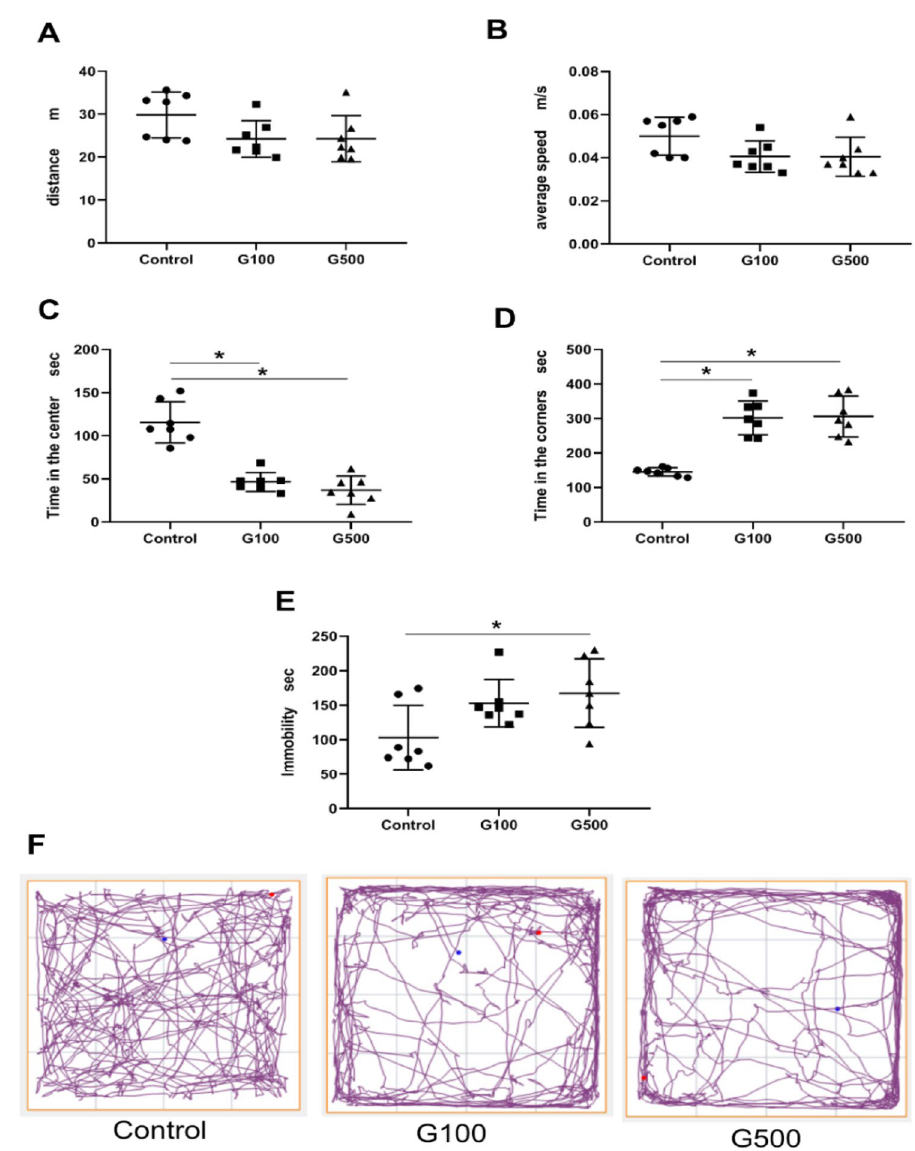
Fig. 1 Effect of low and high dose of Garcinia extract on total distance ( A ), average speed ( B ), time in the center ( C ), time in the corners ( D ) and total immobility ( E ) expressed by the treated mice in the open field test (OF). The locomotion pattern is illus- trated ( F ). Data are plotted as mean ± SD (n = 7). *Significantly different from